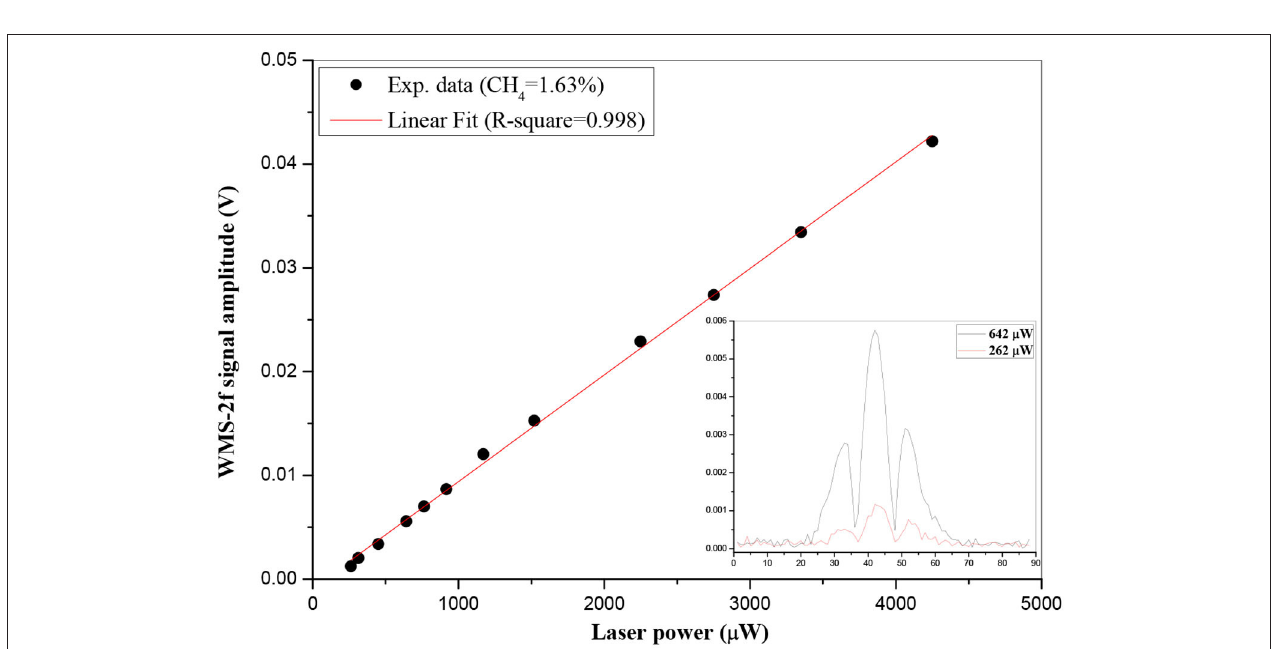
FIGURE 8 | Dependence of the QCTF signal amplitude on the incident laser power.